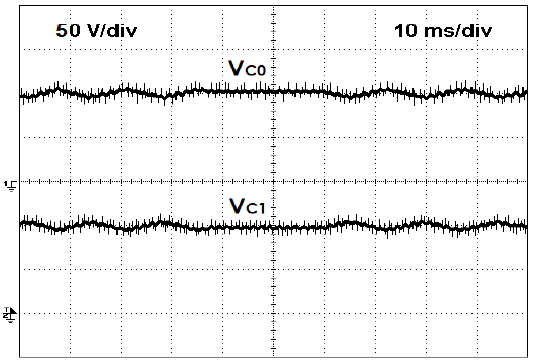
Figure 22. Experimental test with the converter operating in normal mode, then with a short-circuit fault in the semiconductor S 24 and then in fault-tolerant mode ( a ) winding voltage of phase D ; ( b ) winding currents.